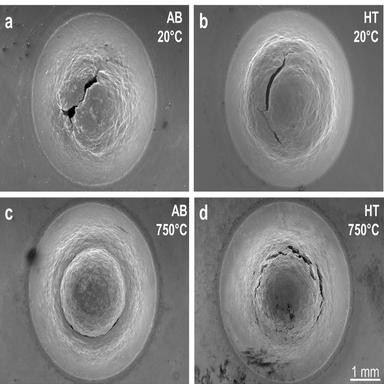
Fracture surfaces of SP tested LPBF DSS 2205 in both as-built and heat-treated conditions, at 20 and 750 ◦C.